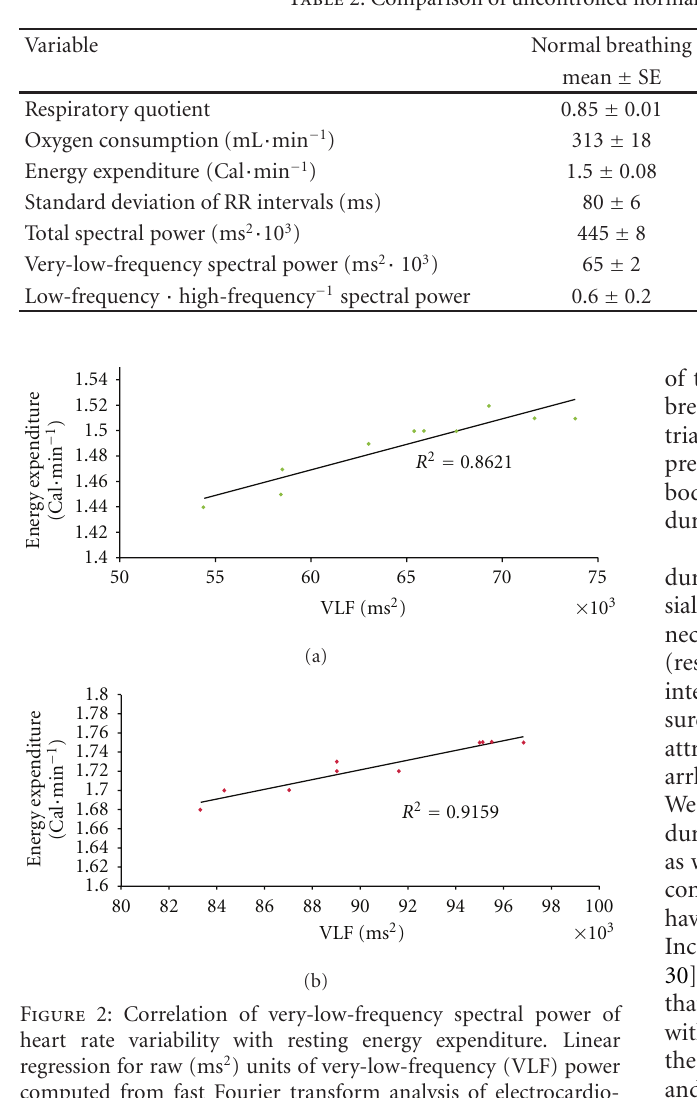
levels [22], and greater lipolytic activity of adipocytes